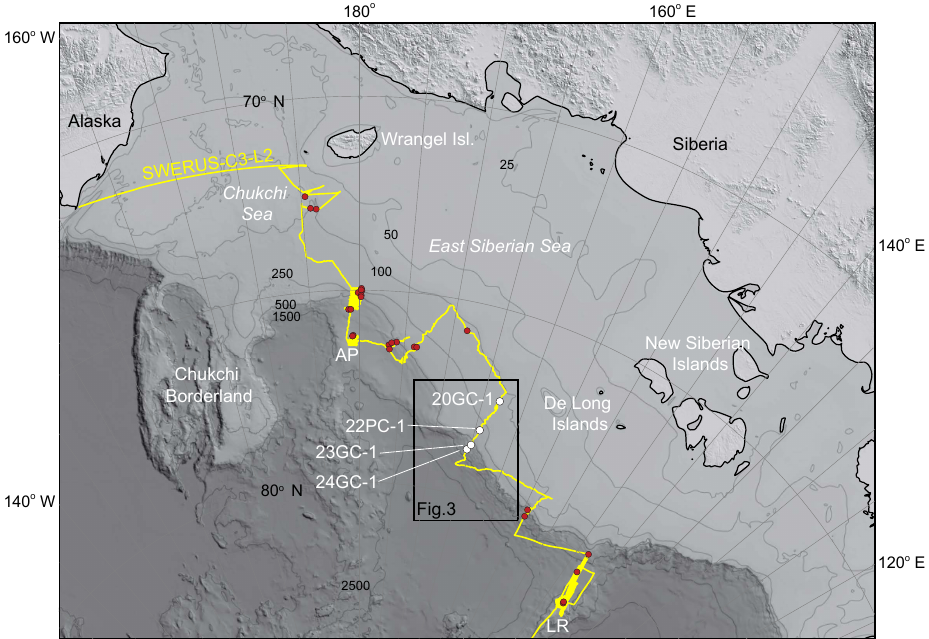
Figure 2. Ship track and coring sites during SWERUS-C3-L2. Location of the geophysical data and sediment cores discussed in this paper is